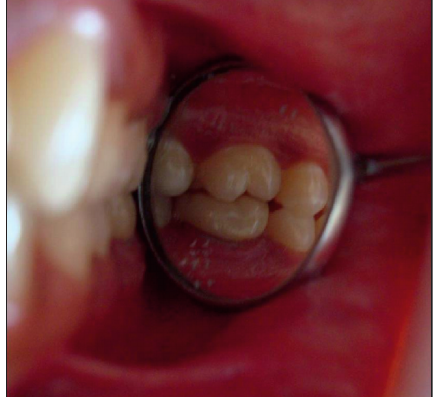
Figure 7: Occlusal view showing the amount of residual tooth structure postobturation.